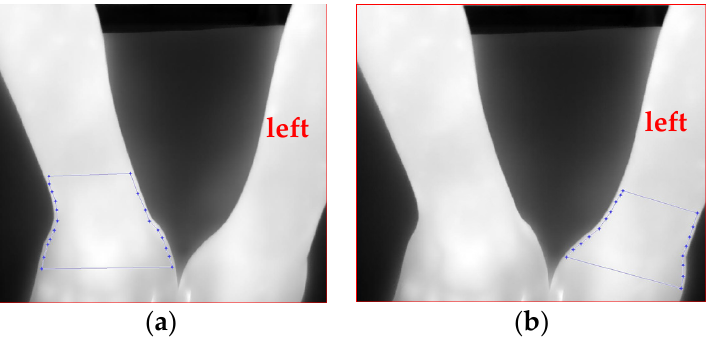
Figure 3. IR thermal images indicating the region of interest as a dotted line: ( a ) sprained left wrist; ( b ) contralateral uninjured right wrist.